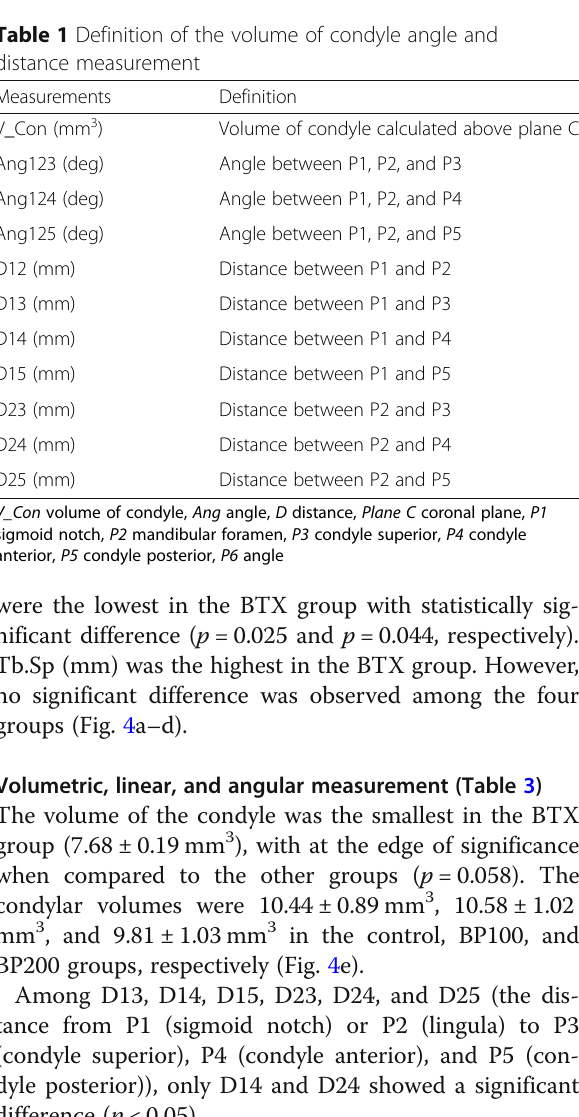
Table 2 Microscopic computed tomography ( μ CT) analysis of the left condyle Control ( n = 4) BTX ( n = 3) BP100 ( n = 3) BP200 ( n = 4)